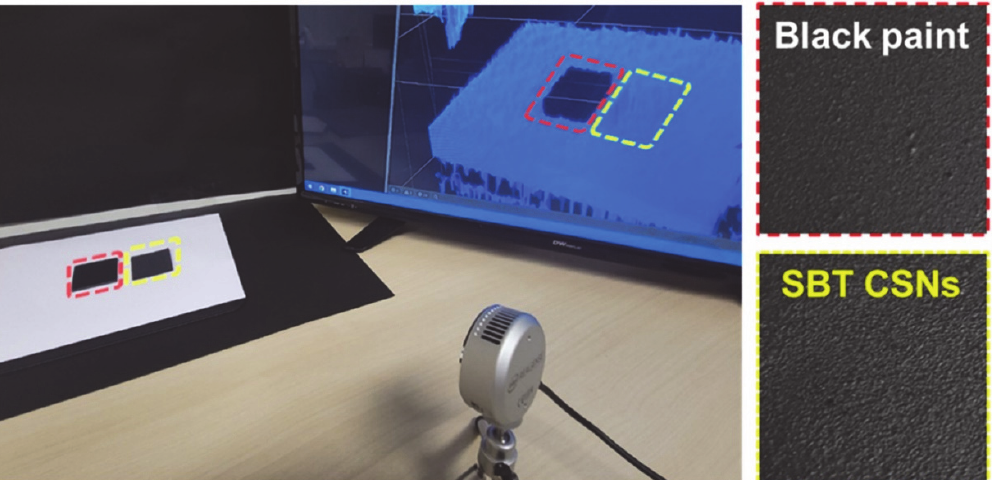
Figure 12. Digital photograph of 140 nm SBT CSN-based and black paints (monolayer on glass substrate) and their practical images on display by LiDAR sensor employing a 905 nm wavelength (LiDAR operation in depth mode).